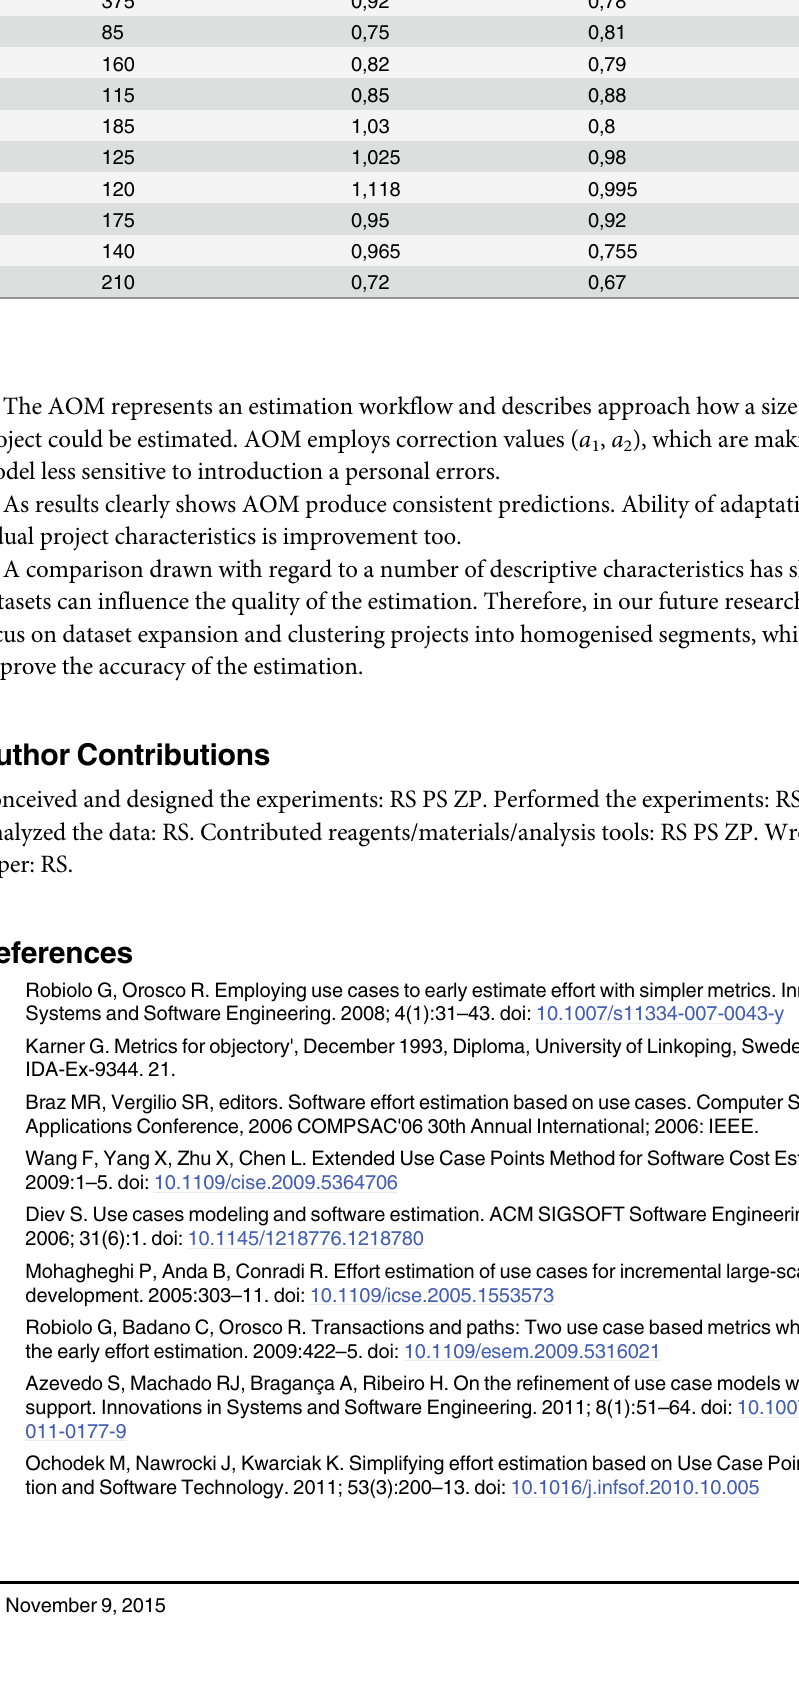
Table 9. Case Study Historical Data Points. Project